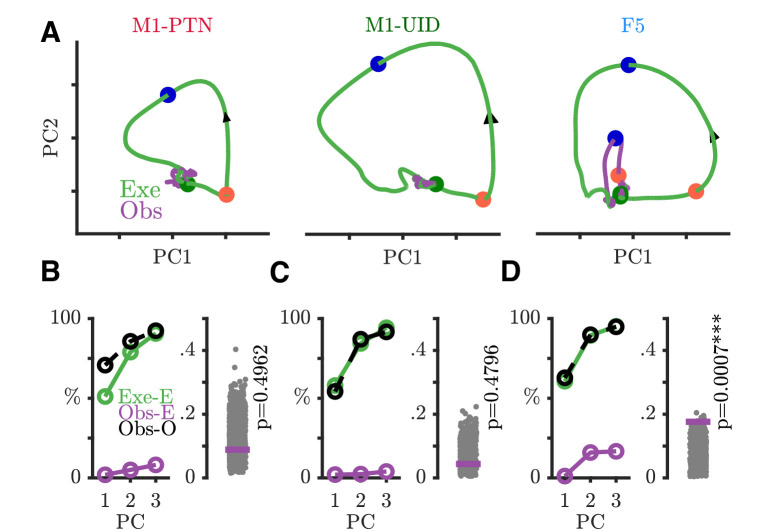
WHG execution and observation activity in execution movement subspace.Evolution of neural trajectories through trial in WHG movement subspace. All plotting conventions as in Figure 7A–D.